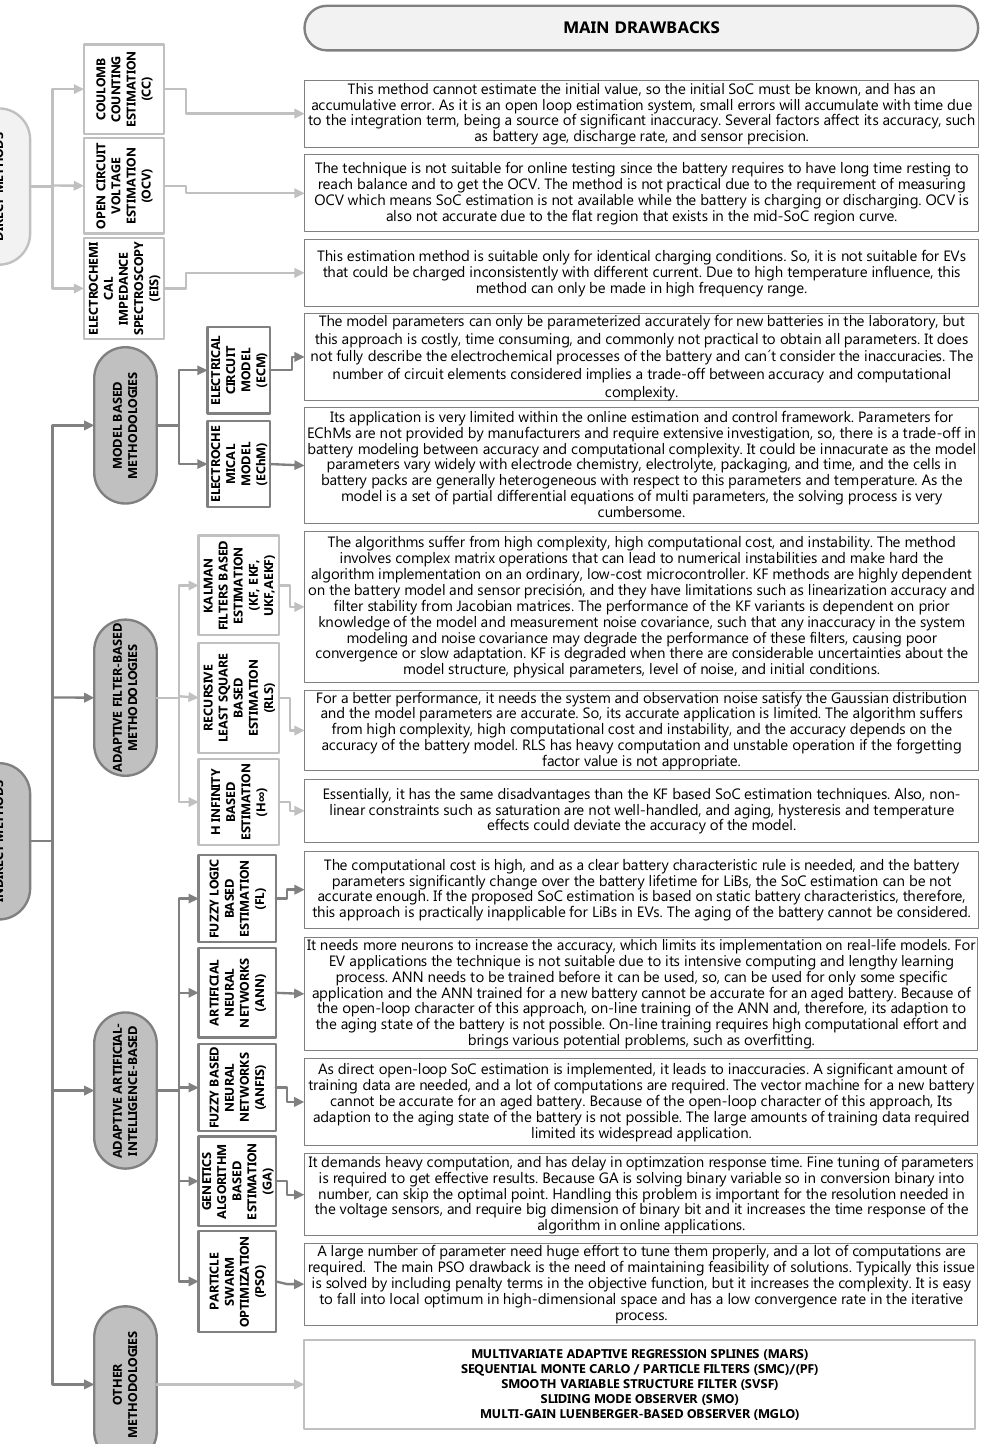
SLIDING MODE OBSERVER (SMO) MULTI-GAIN LUENBERGER-BASED OBSERVER (MGLO)